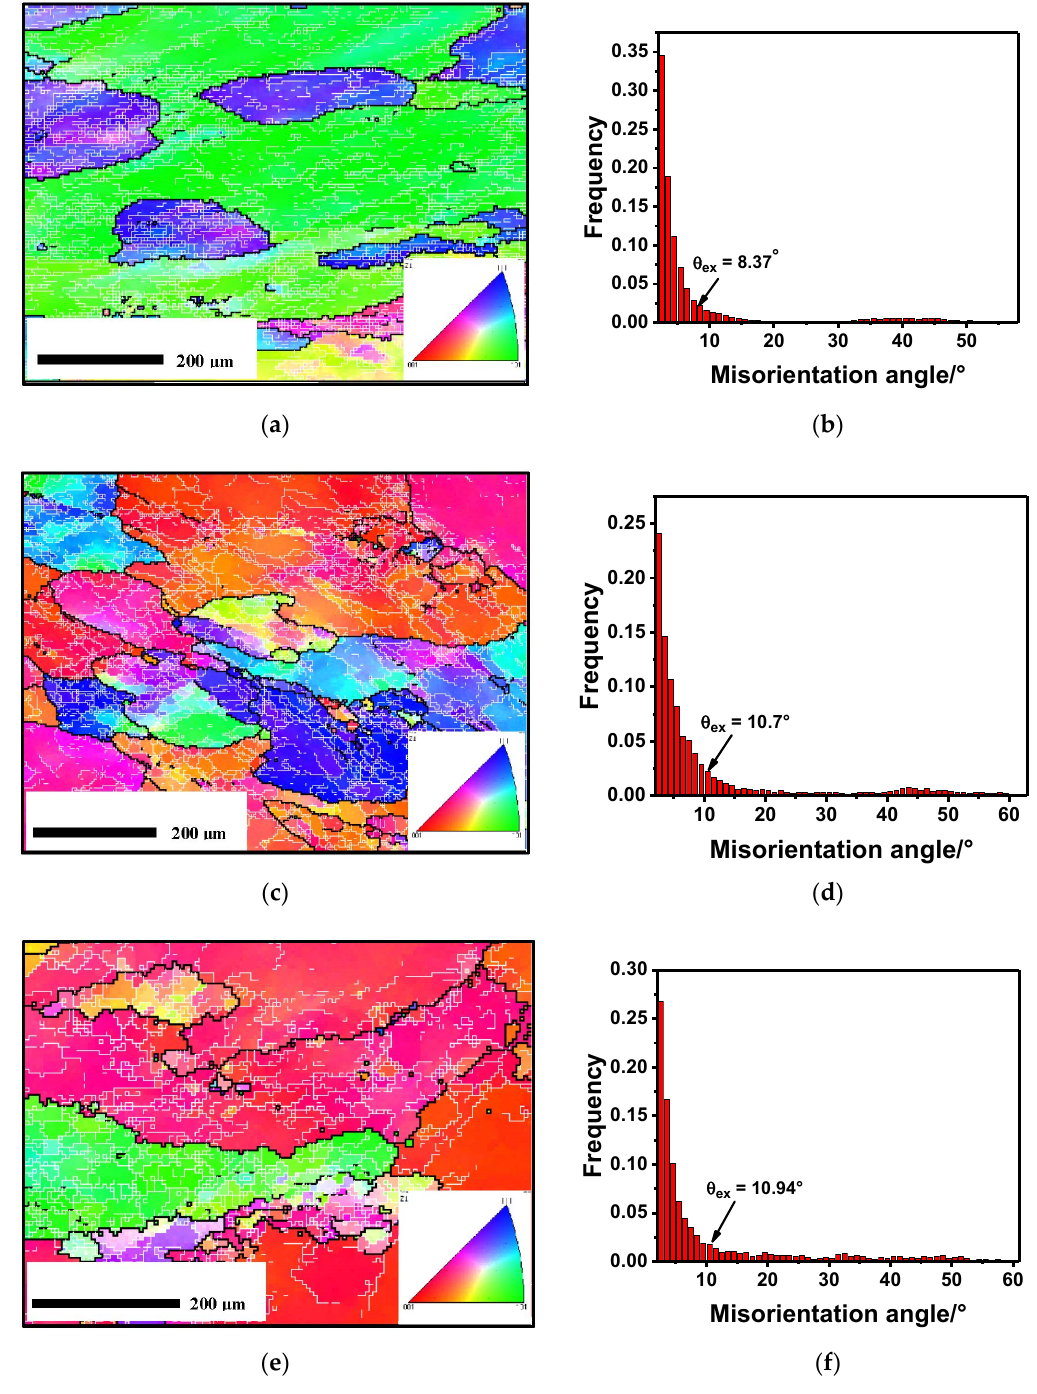
Figure 5. OM and GB figures under the conditions of: ( a ) 623K–0.1/s–60s–0.36; ( c ) 723K–0.1/s–60s–